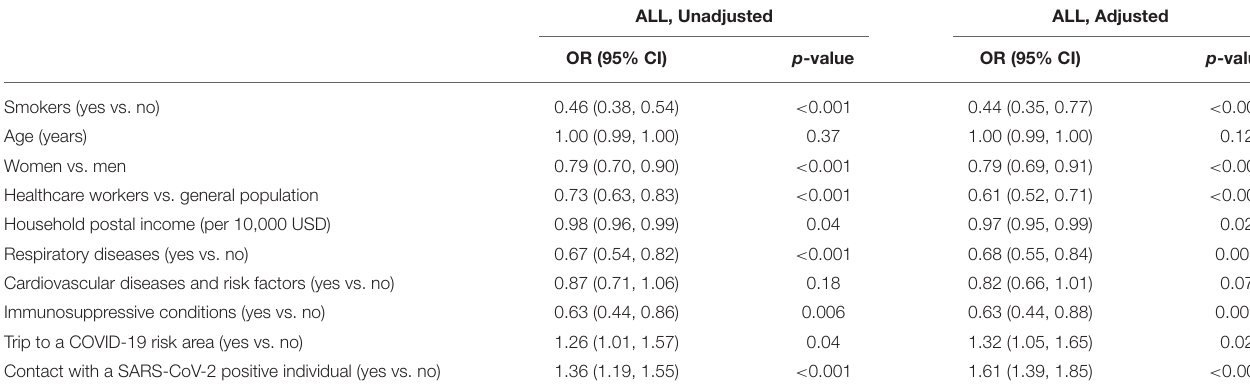
TABLE 2 | Association of smoking and positive testing for SARS-CoV-2 and potential related